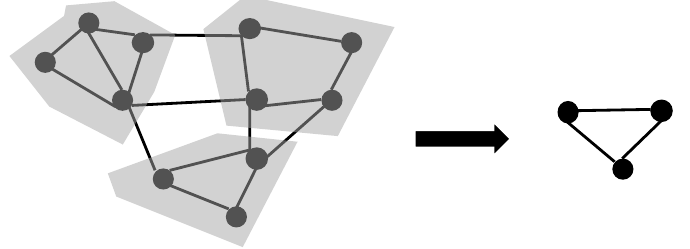
Figure 2. Left : the original graph G 0 . Right : its coarsened graph G 1